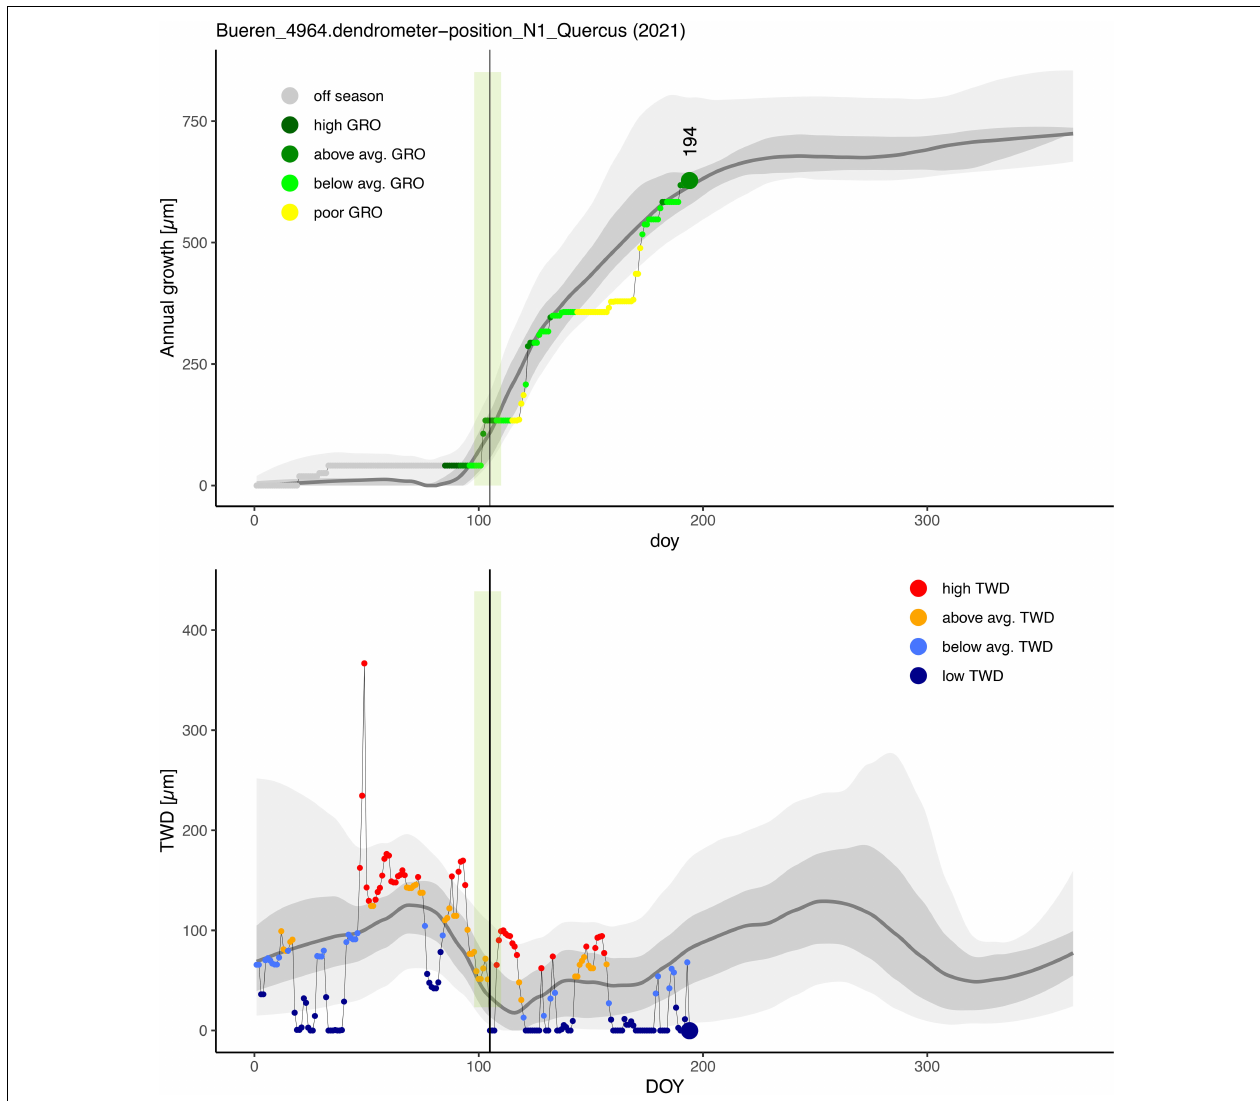
FIGURE 5 | Performance of an oak tree at the site Bueren until the day of the year (DOY) 191 in the year 2021, in terms of stem growth (GRO, upper panel) and tree water deficit (TWD, lower panel). The grey colored areas indicate the 5–95% percentile range (light grey) and the 25–75% percentile range (dark grey) of all available years (L2M data). The grey line indicates the median of the respective data. The colored symbols (L2 data) indicate whether a tree is currently growing poorly (yellow, < 25% percentile), below average (light green, 25–50% percentile), above average (green, 50–75%) or highly (dark green, >75%) relative to the years before. The period outside the potential stem growth time is indicated with grey circles and the label ‘off season’. Analogue for TWD, low TWD (black blue, < 25% percentile), below average (light blue, 25–50% percentile), above average (orange, 50–75% percentile) or high TWD (red, >75% percentile). The vertical black line with the green area indicates the median DOY when stem growth of a season crosses the 5% threshold of annual growth (based on historic LM